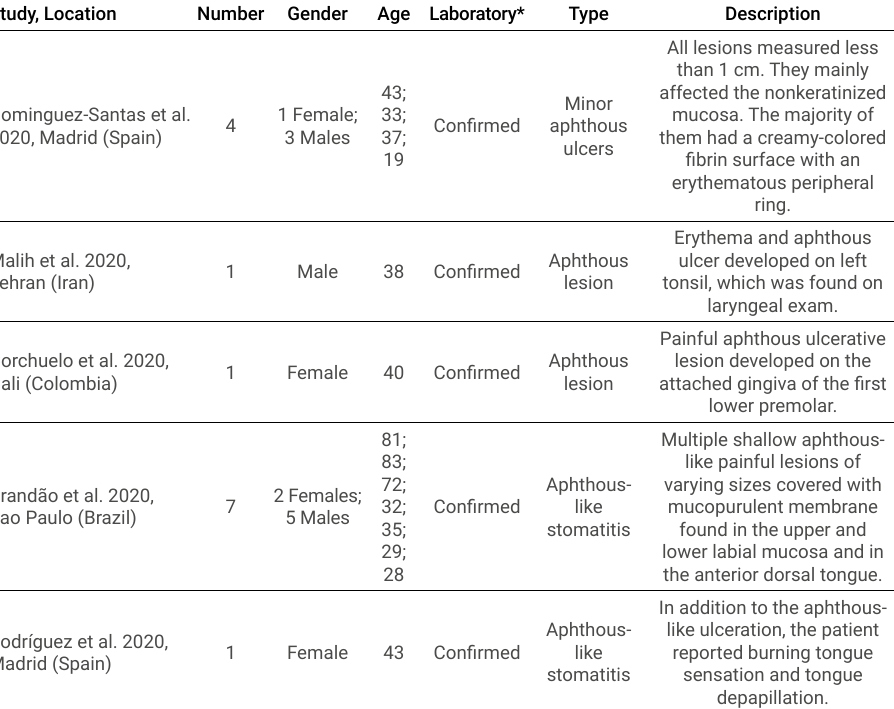
Table 1. COVID-19 patients with aphthous lesions Study,